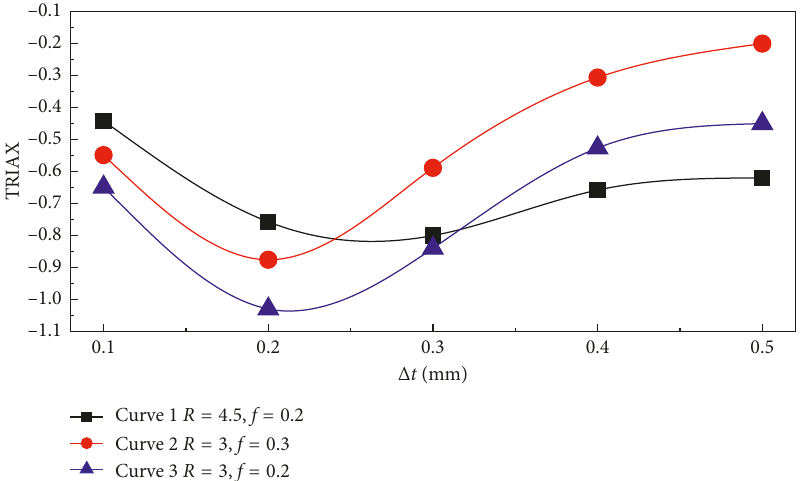
Figure 7: Graph of change in AVRST with thickness